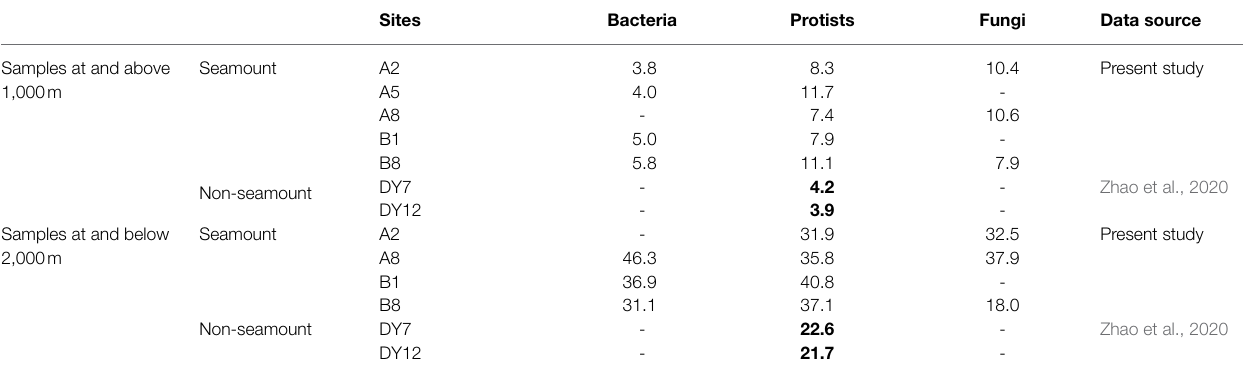
TABLE 3 | Proportions (%) of OTUs shared between samples from the vertical profile of each site. Sites Bacteria